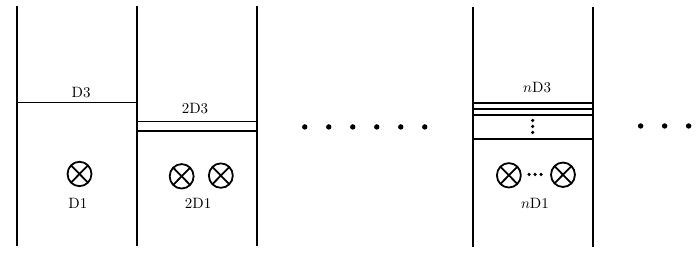
Figure 5 . Brane set-up underlying the non-Abelian T-dual solution. The D3-branes are wrapped on S 2 , such that the e(cid:11)ective (cid:12)eld theory living in them is one dimensional at low energies.